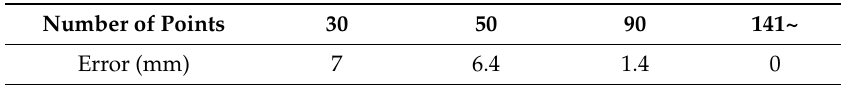
Table 1. The tendency of distance error with the desired FFP position by increasing the number of point utilized in a weighted-norm solution. Number of Points